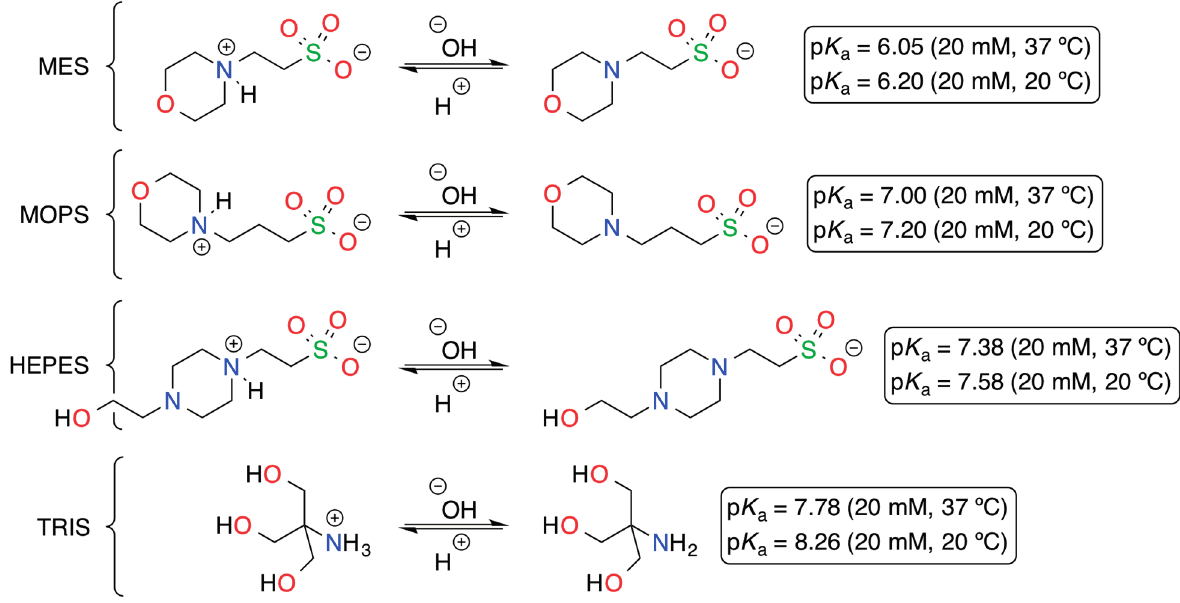
Figure 1. Dissociation steps and pK a values at 25 °C and 37 °C of the buffers used in this work (values estimated at 20 mM concentration) [26]. Buffer names: MES = 2-(N-morpholino) ethanesulfonic acid; MOPS = 3-(N-morpholino)propanesulfonic acid; HEPES = 4-(2- hydroxyethyl)-1-piperazineethanesulfonic acid; TRIS =